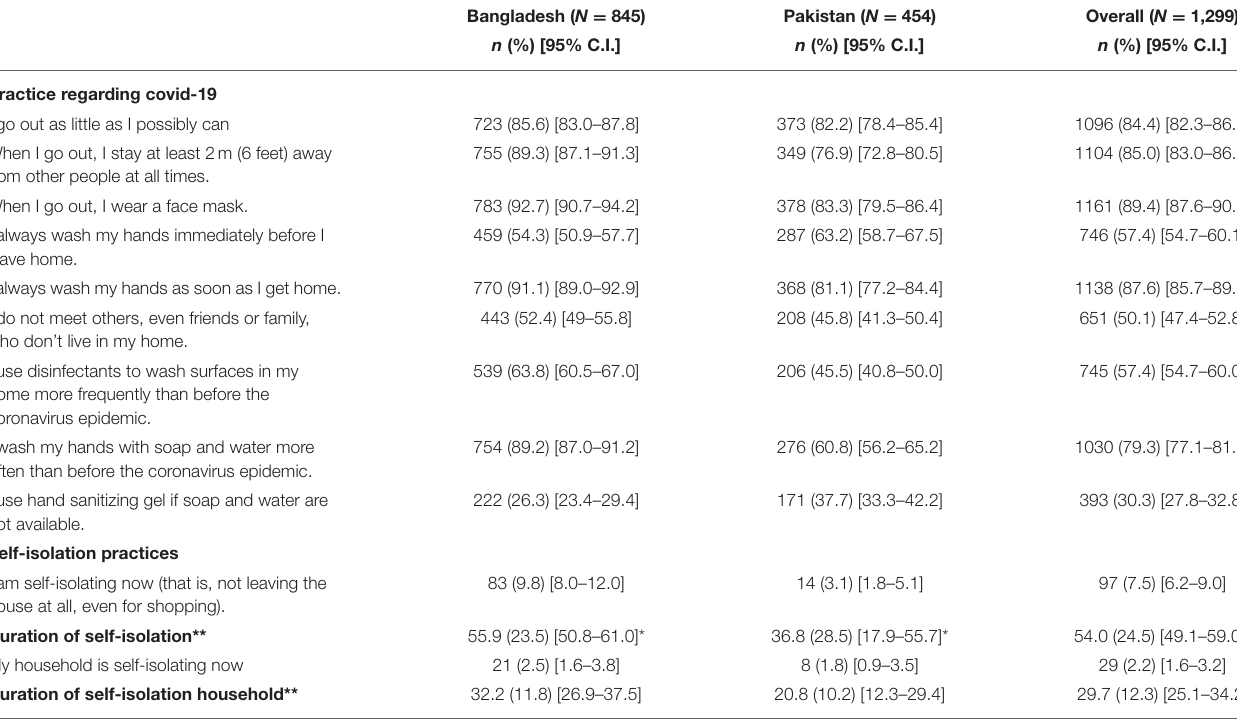
TABLE 4 | Attitudes and practice relevant to the COVID-19 epidemic. Bangladesh ( N = 845) Pakistan ( N = 454) Overall ( N =